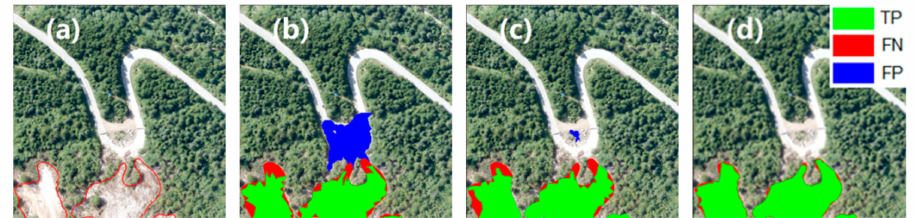
Figure 13. Error landslides extractions. ( a ) Originally visual interpretation. ( b ) Extractions of ResNeXt50. ( c ) Extractions of ResNeXt50 + Improved FPN. ( d ) Extractions of ResNeXt50 + Improved FPN + L edge .